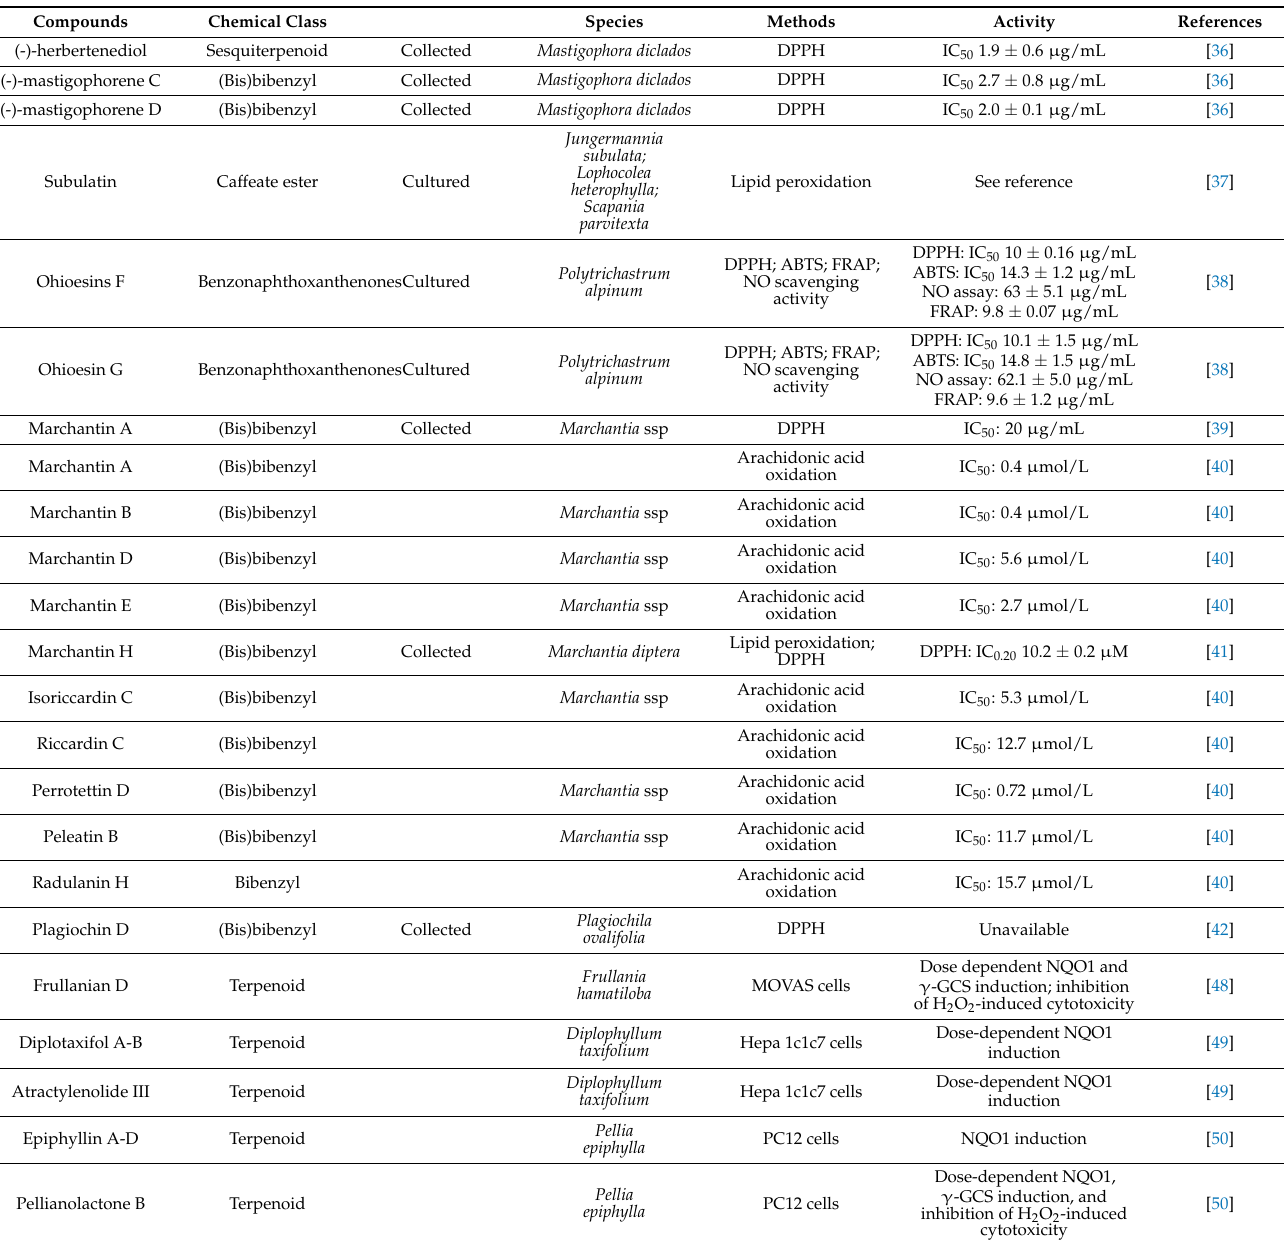
Table 2. List of pure isolated compounds tested for in vitro antioxidant